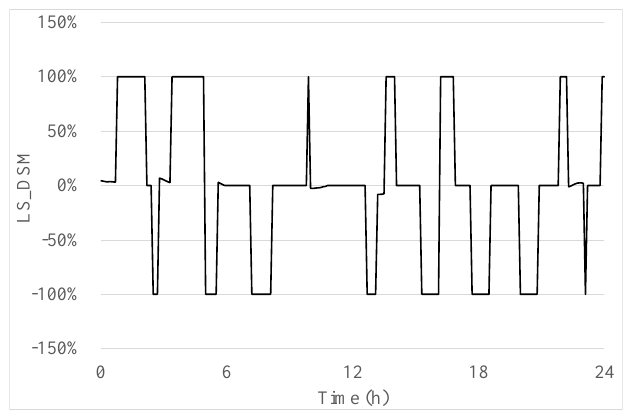
Figure 9. Load shifting indicator ( LS DSM,t ) for the comparison between the system with or without the DR program.